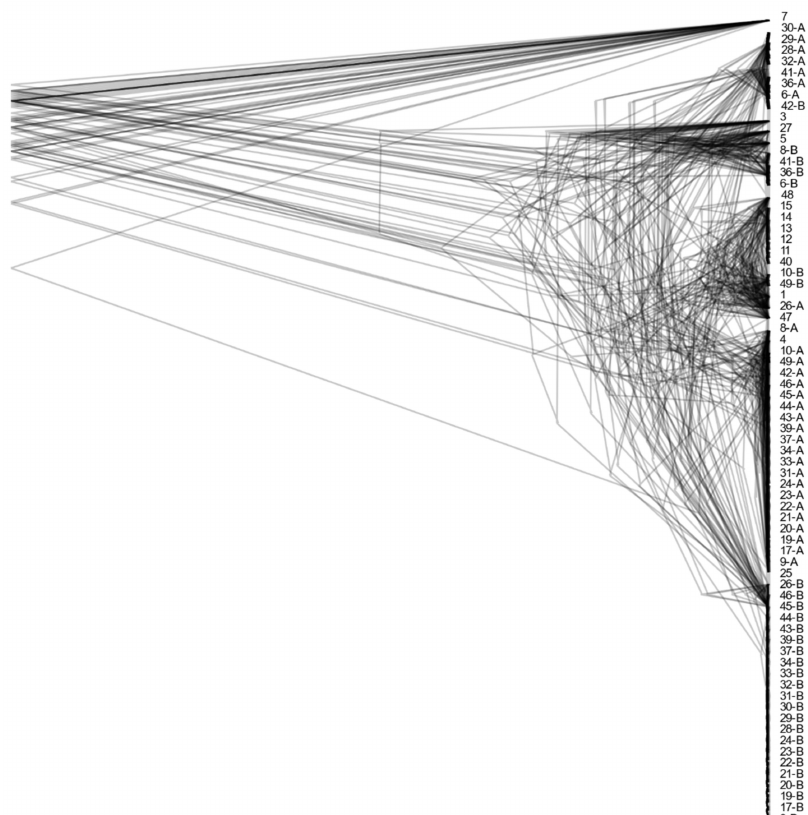
Figure 5. Phylogeny of A. melanogenum strains. Overlay of gene trees of 44 Benchmarking Universal Single-Copy Orthologs (BUSCOs). The trees were estimated by PhyML 3.1 using the Hasegawa– Kishino–Yano 85 nucleotide substitution model and estimating the alpha parameter of the gamma distribution of the substitution rate categories and the proportion of invariable sites. The numbers in the tree represent the source genomes (1–49) as numbered in this study. Duplicate genes from the same genome are marked with letters »A« and »B«.